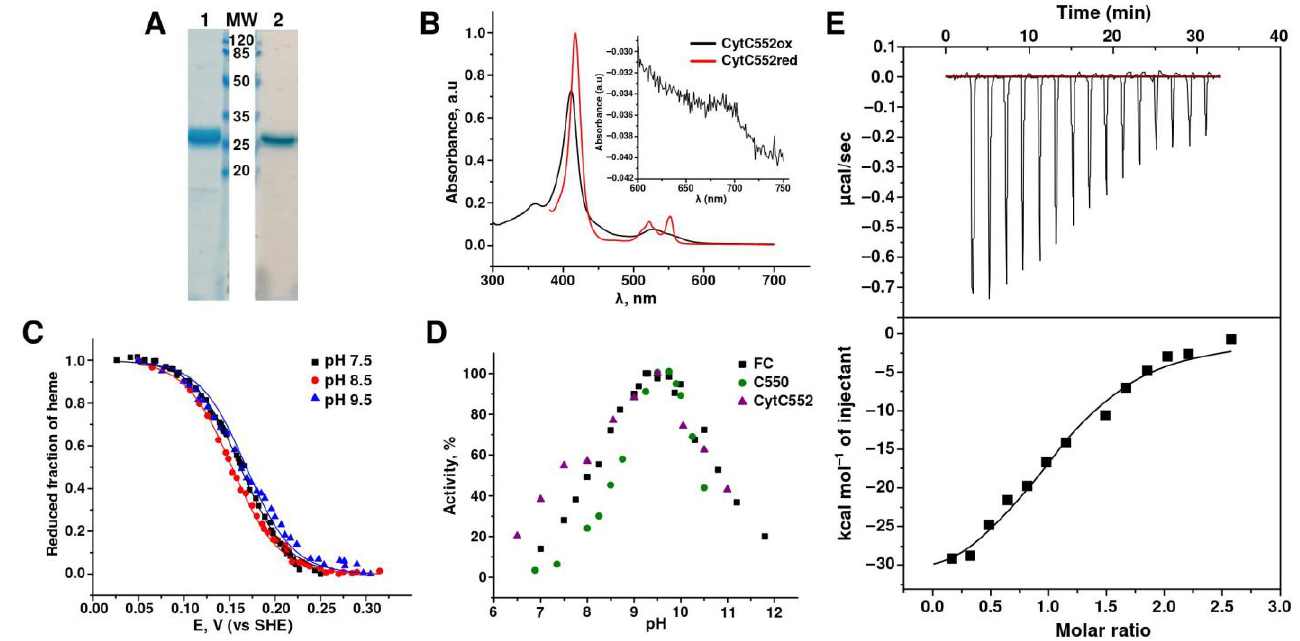
Figure 1. Characteristics of recombinant CytC552. ( A ) Assessment of homogeneity of CytC552 by 15% SDS-PAGE: 1-Coumassie Blue R staining, 2-heme c staining, MW-molecular mass (kDa) markers. ( B ) UV–visible spectra of the CytC552 oxidized form with characteristic peaks at 411 and 528 nm and reduced form with peaks at 417, 522, and 552 nm. ( C ) Redox titration of CytC552 at different pH values: 7.5, 8.5, and 9.5. The fraction of the protein reduced for each spectrum was calculated from A 552 – A 568 (A 568 — absorption in an isobestic point). ( D ) pH-dependence of TcDH activity in the reaction of thiocyanate oxidation with CytC552, hhCytC550, and ferricyanide (FC) as electron acceptors. ( E ) Evaluation of the TcDH-CytC552 complex by isothermal titration calorimetry (ITC) .